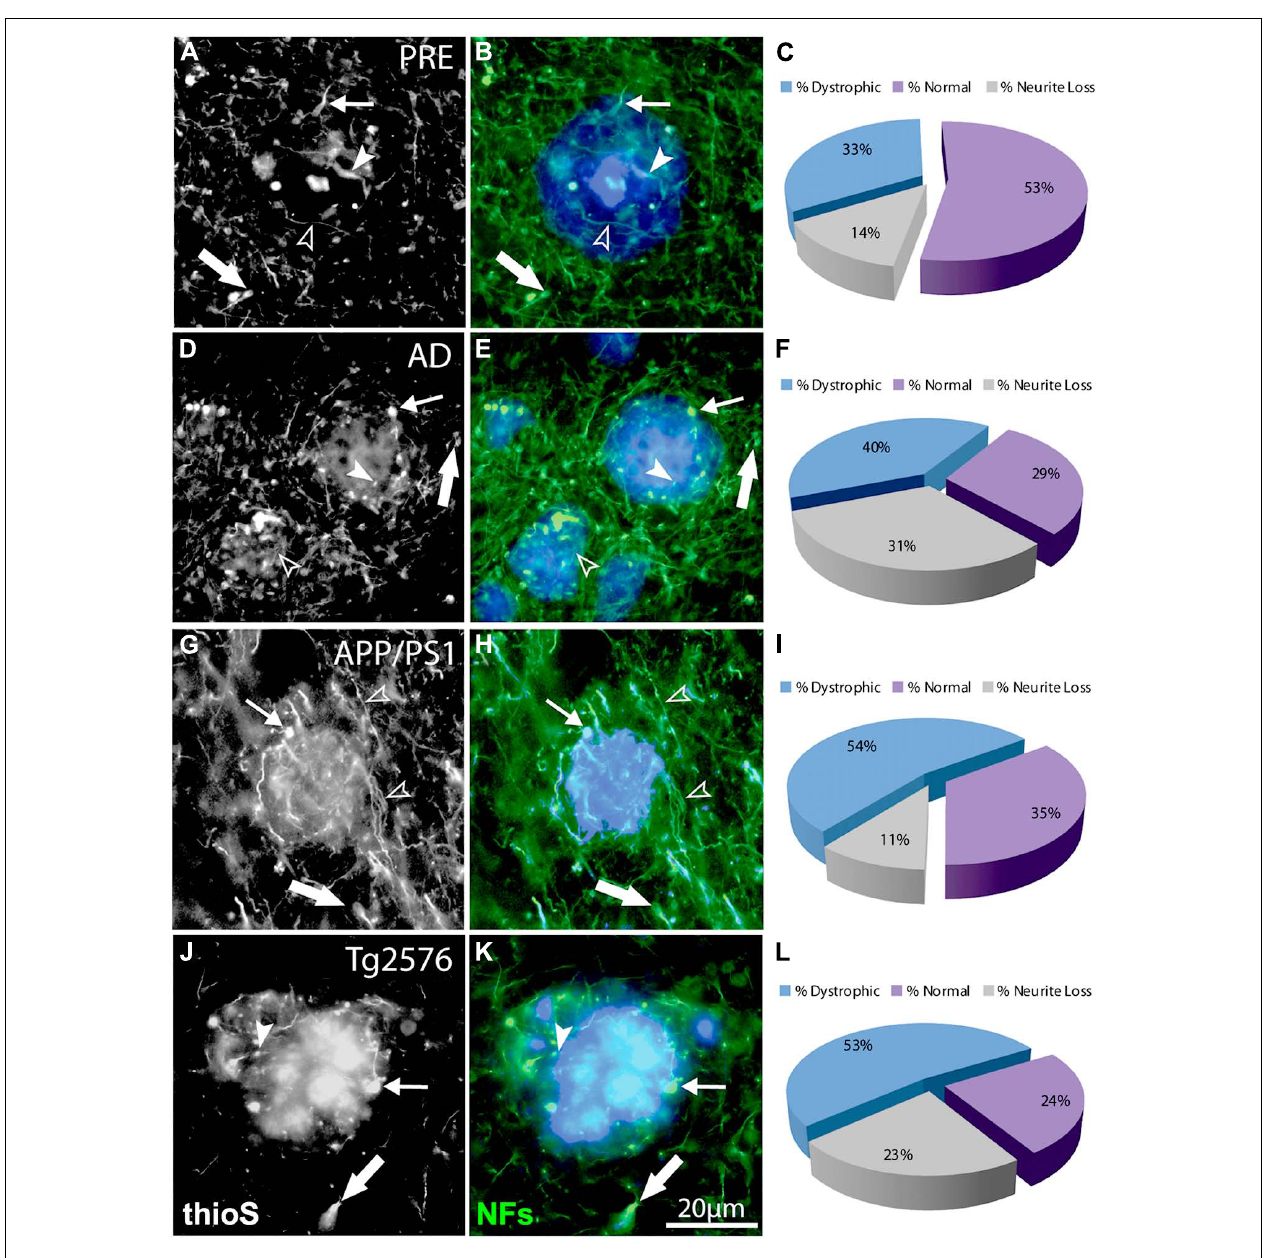
edge, and large arrows in the periphery. Normal-appearing neurites in association with thioflavin-S labeled fibrillar plaques are indicated by unfilled arrowheads. A large proportion of NF + neurites associated with A β plaques are dystrophic (blue fraction: C,F,I,L ) and there is extensive neruite loss in end-stage AD and Tg2576 mice (gray fraction: F,L